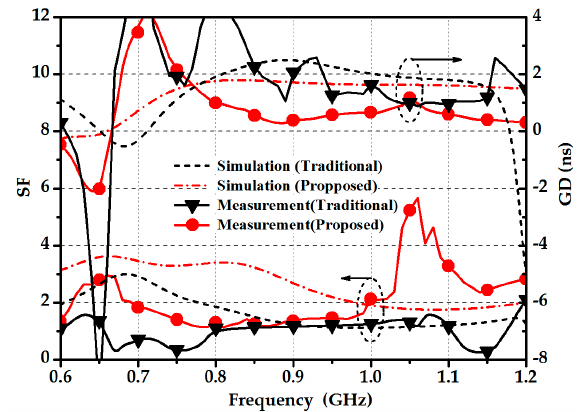
Figure 10. Simulated and measured SF (stability factor) and GD.